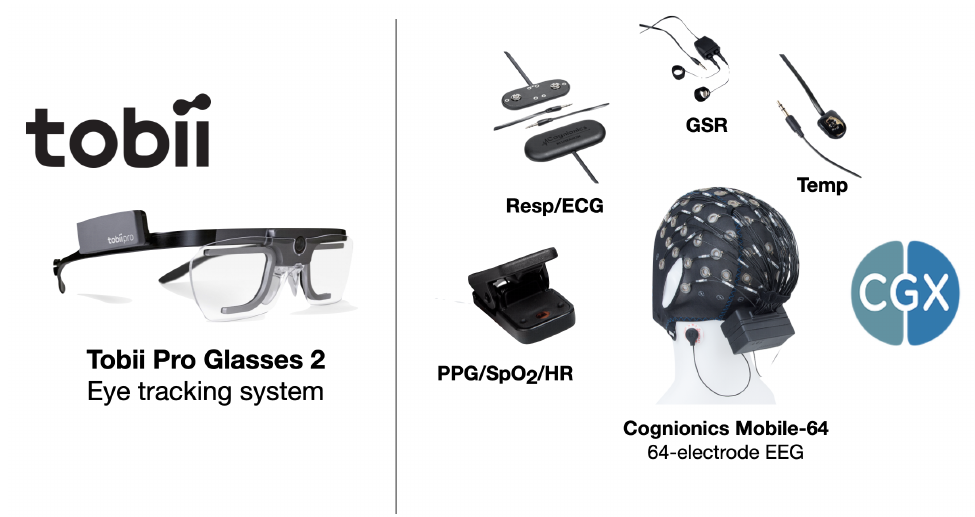
Figure 1. Biometric sensing systems. ( Left ) Tobii Pro Glasses 2 eye tracking system. This instrument performs eye tracking data, pupillometry, and provides two videos streams of the participant’s POV and eyes, respectively; ( right ) Cognionics Mobile-64 and AIM2 systems. Sensing suite includes 64-electrode EEG, PPG which measures SpO 2 and HR, respiration/ECG sensors, GSR, and temperature